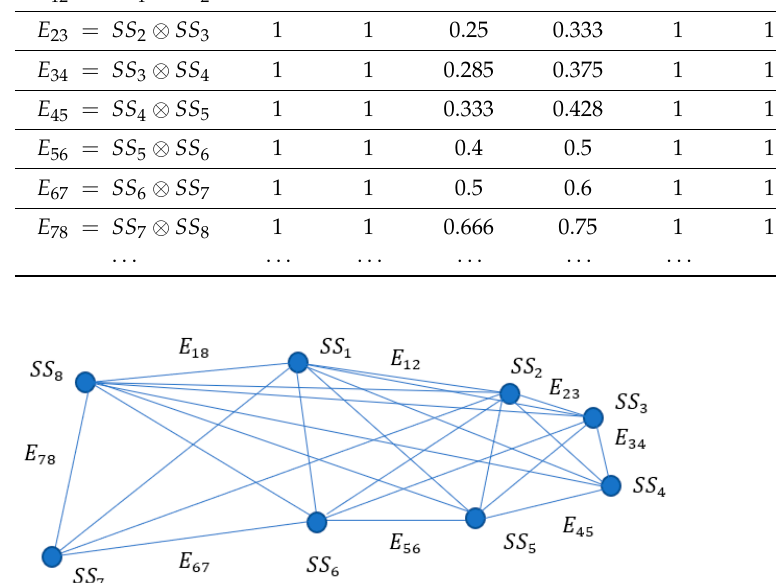
Table 3. Membership values of the edges.